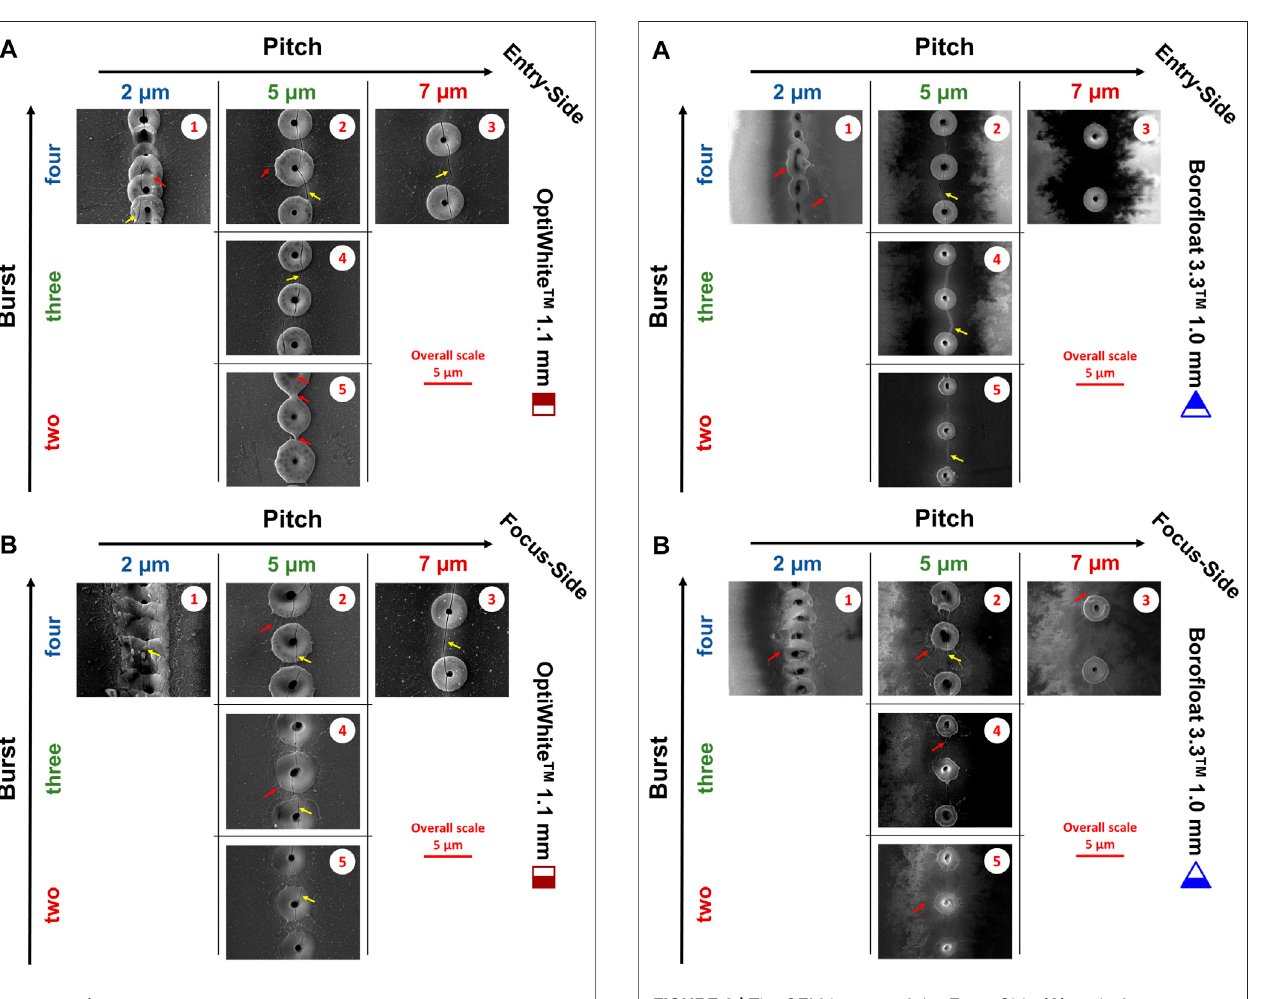
left to right and pulse number within one Burst from bottom to top. The scale bar is attached to the right of the images. Numeration in the top right corner is set to better address speci fi c image. Surface modi fi cations show partially strong melting and overlapping fl ow (red arrows) but also discrete round regular shapes. Small fi ne sprinkles of fl uid material (red arrows) point out the fl uid character during formation. Condensed matter and expelled material are found in the environment. Continuous surface cracks are observed (yellow arrows), except for B5.